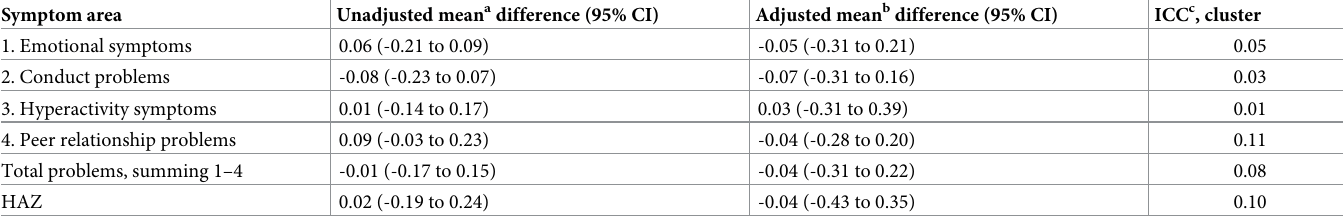
Table 7. Emotional-behavioural symptom results from the Strengths and Difficulties questionnaire, parent version. HAZ: Height for age z-score. Country-pooled results showing linear regression unadjusted and adjusted models with EBF status at 12 weeks as the dependent variable, 1-week recall. Symptom